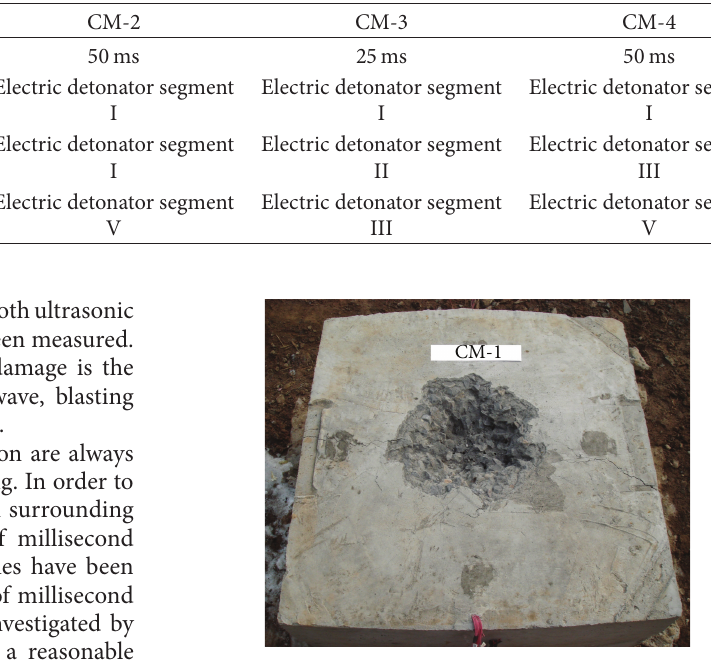
Figure 1: Blasting effect of concrete model with three-circle blast-